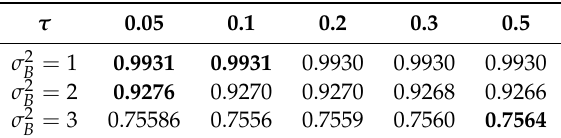
Table 6. Influence of transition width τ for deconvolution for different level of blur ( σ 2 values are given in bold.